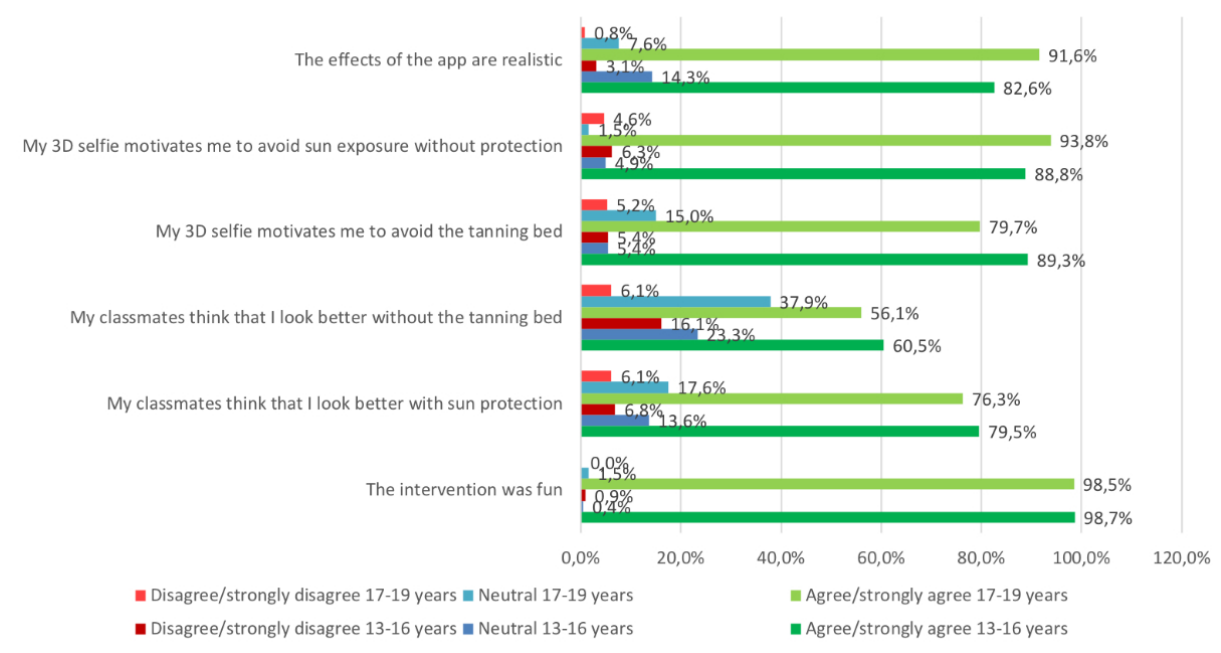
Figure 10. Results in 13- to 16-year-old versus 17- to 19-year-old participants. 3D: